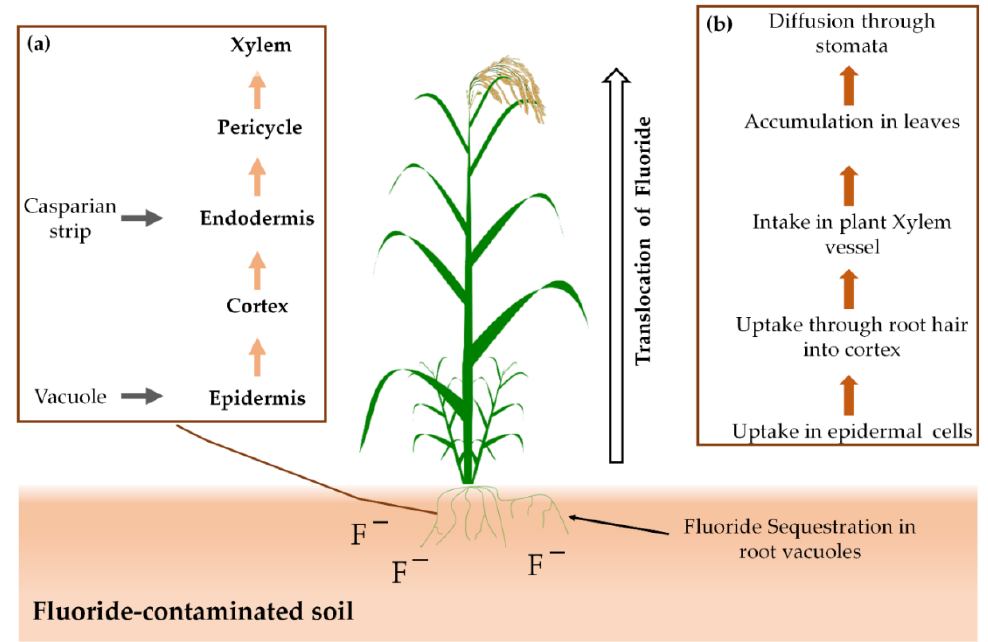
Figure 2. Fluoride uptake and accumulation in plants: ( a ) uptake mechanism in roots and ( b ) overall translocation from roots to shoots.